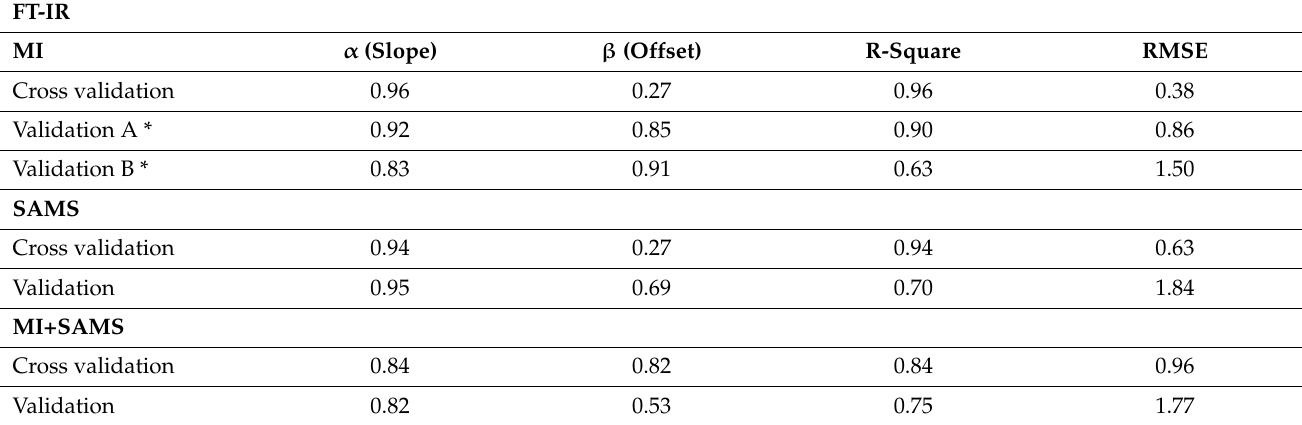
Table 4. Linear regression fit parameters between actual and predicted TVC values for the different